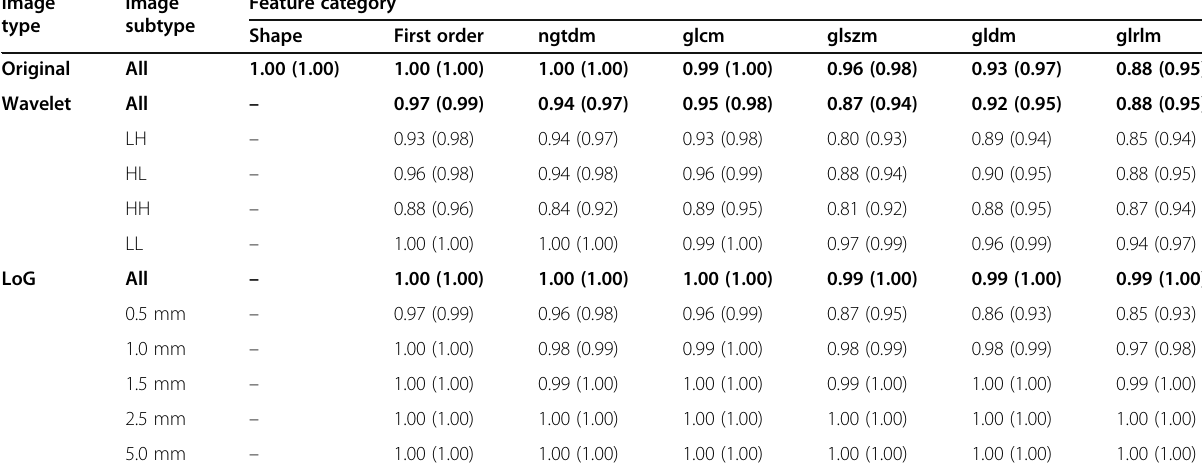
Table 3 Median OCCC values calculated for each image type and feature category